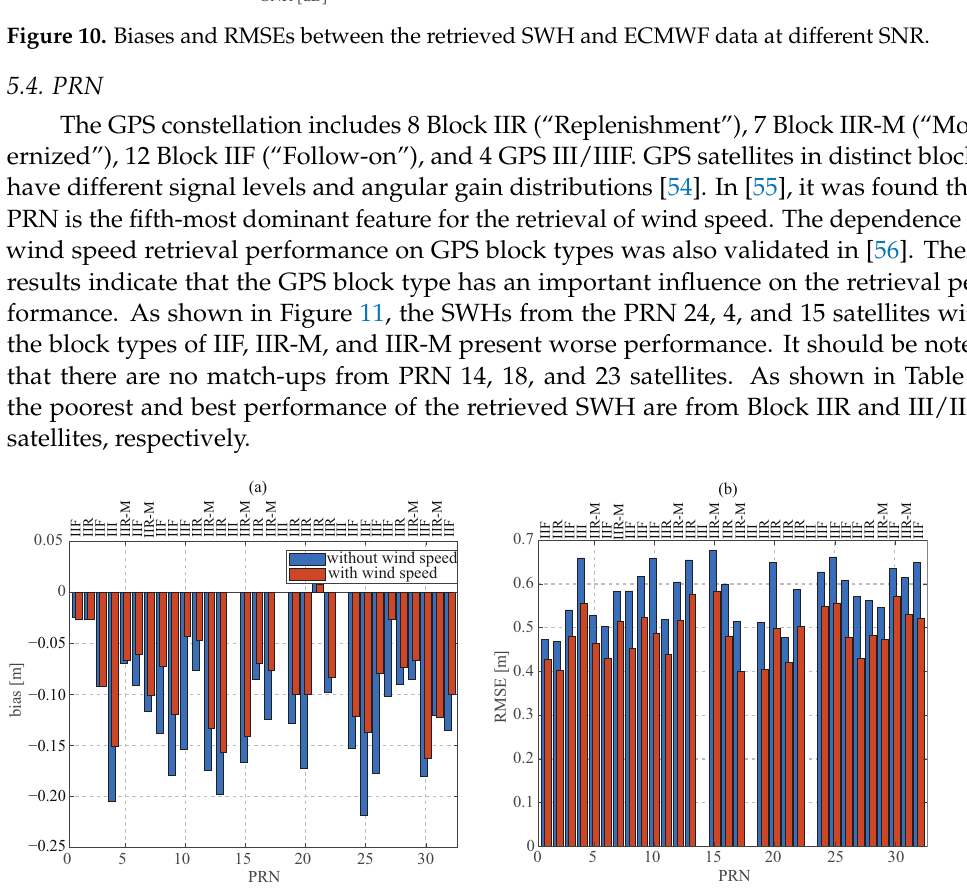
Figure 11. ( a ) Biases and ( b ) RMSEs between the retrieved SWH and ECMWF data at different GPS PRN values. Table 2. Retrieval performance for different block-type